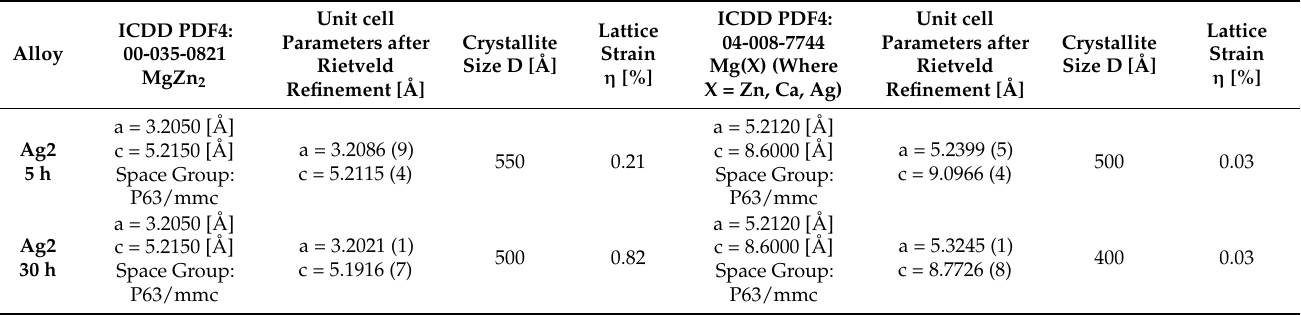
Table 3. Structural parameters, crystallite sizes, and lattice strain for the main phases present in the Ag2 alloy after 5 and 30 h of